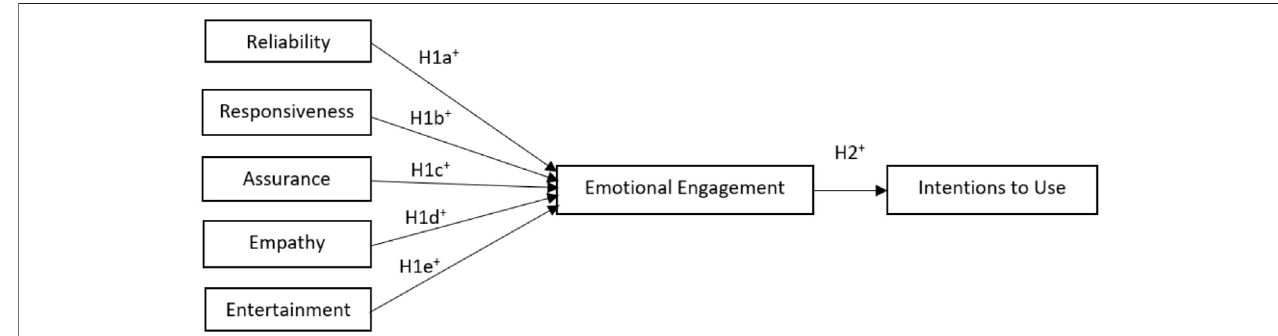
FIGURE 1 | The Servbot model. Hypothesis1a-e: SERVBOT dimensions will be positively linked to users ’ emotional engagement with the social robot in a service setting. H1a: Higher level of reliability will result in higher levels of emotional engagement. H1b: Higher level of responsiveness will result in higher levels of emotional engagement. H1c: Higher level of assurance will result in higher levels of emotional engagement. H1d: Higher level of empathy will result in higher levels of emotional engagement. H1e: Higher level of entertainment value will result in higher levels of emotional